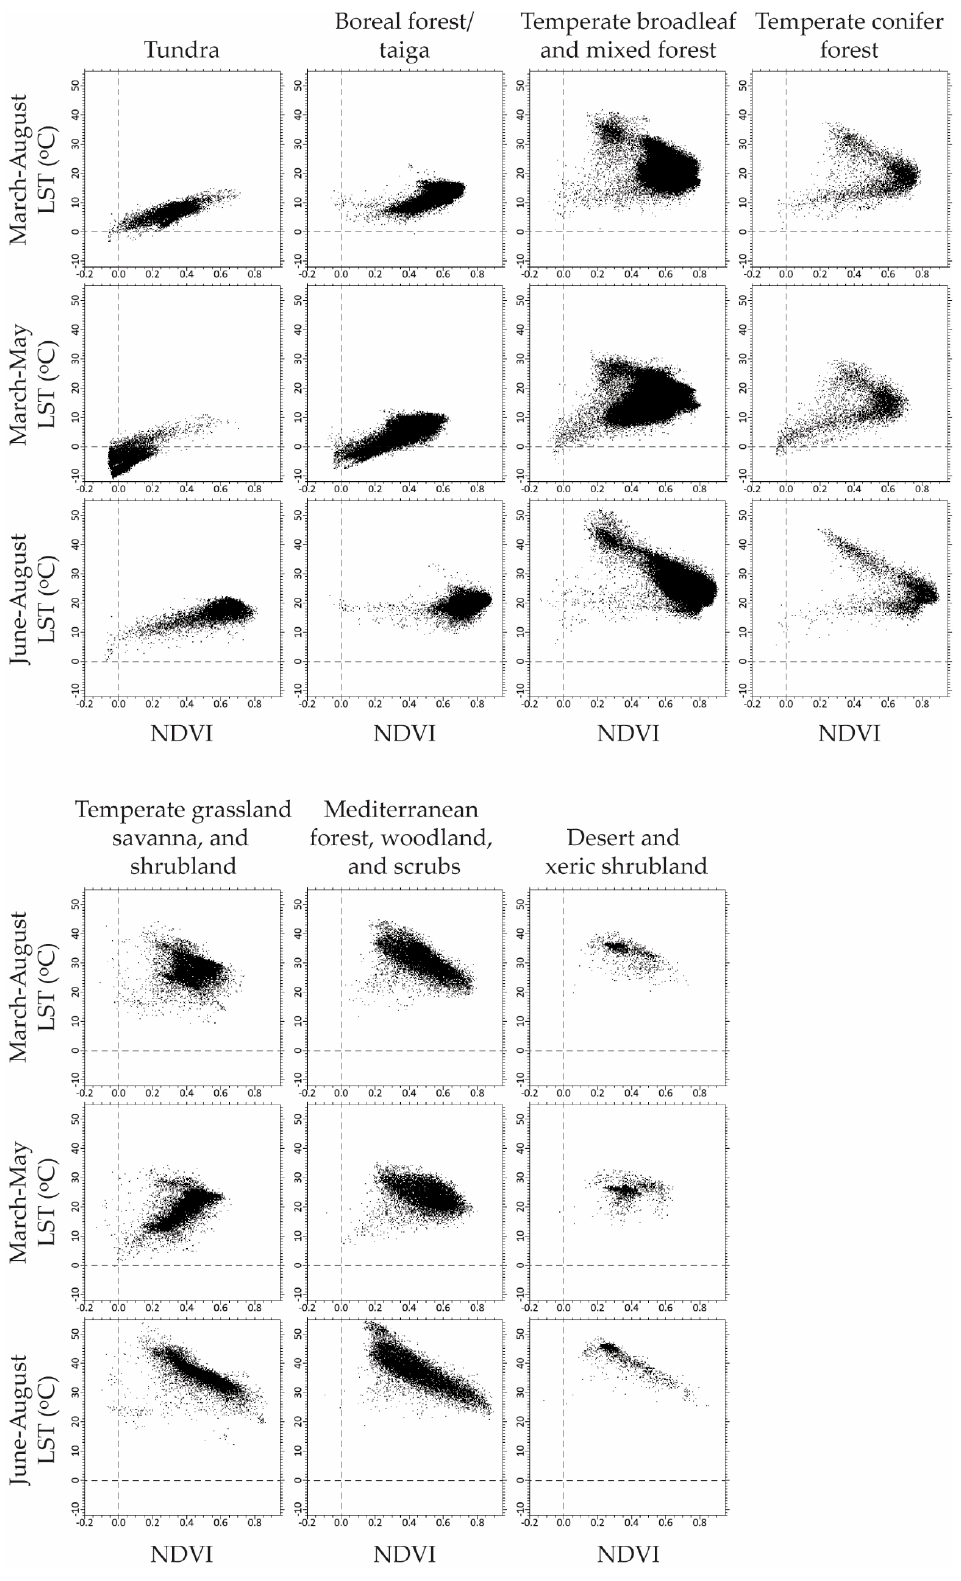
Figure 3. LST–NDVI scatterplots for each biome from March–August, March–May, and June–August.